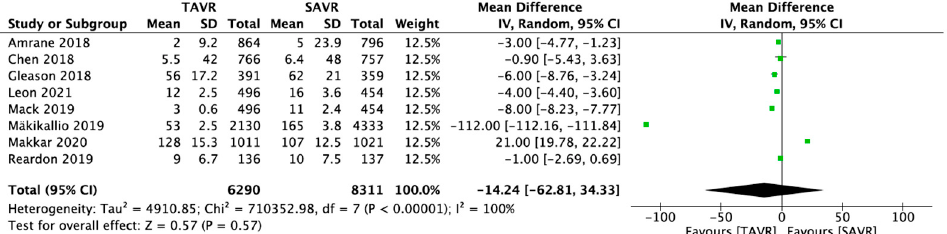
Figure 3. Forest plot of the pooled studies for stroke [18–20,26–30].